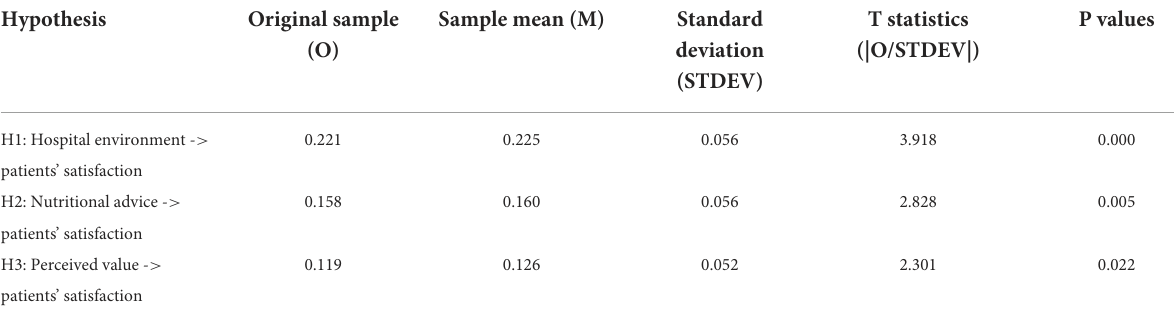
TABLE 3 The Direct effects of HRM practices on operational